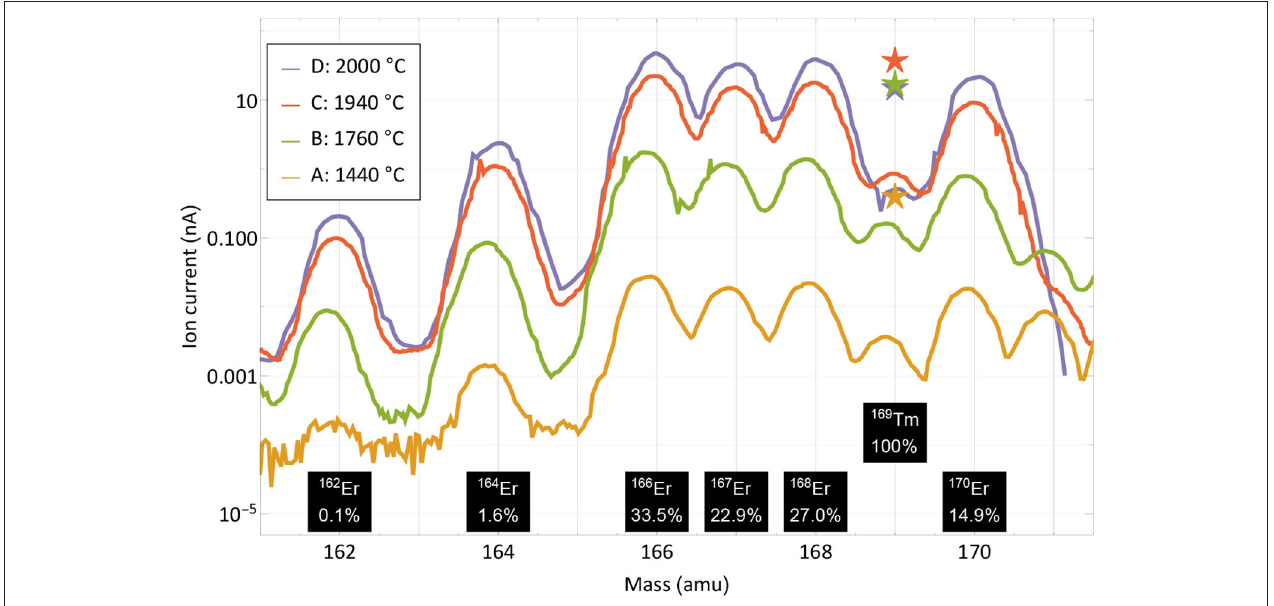
FIGURE 4 | Mass scans of the thulium and erbium region performed at different occasions and temperatures as marked in Figure 3 . The scans were performed without lasers, the respective measured ion current on mass 169 with lasers is marked with star markers. Natural abundances of erbium and thulium are